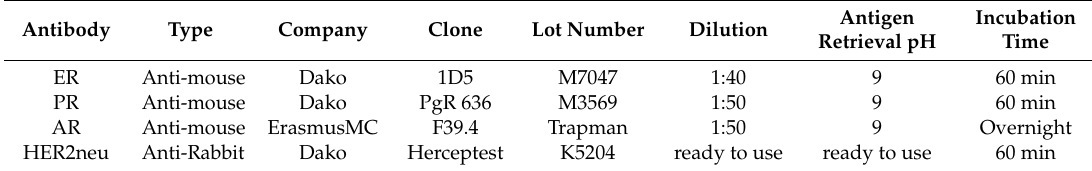
Table 4. Antibody characteristics and used protocol for immunohistochemistry.